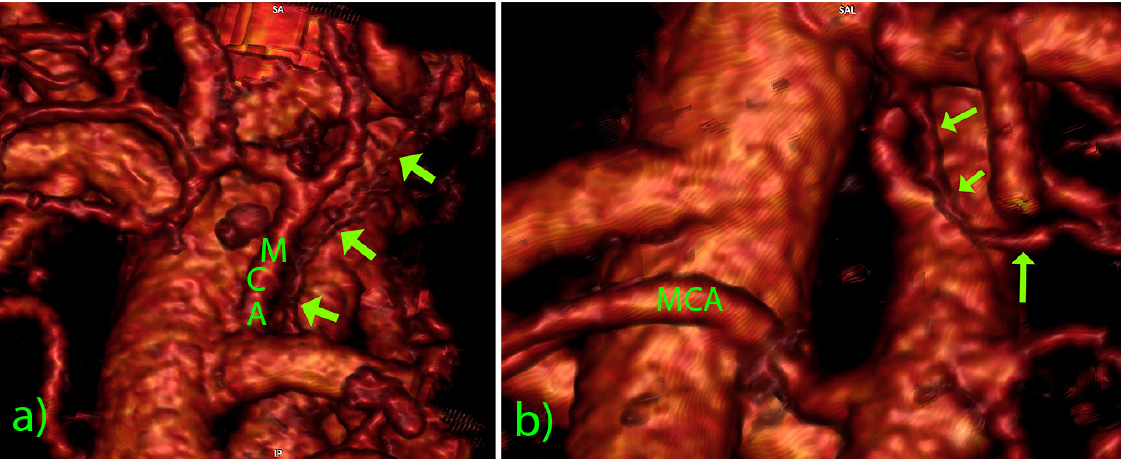
Figure 3. Three-dimensional volume rendering of lymph vessels (arrows): ( a ) longitudinal vessel paralleling the MCA; ( b ) oblique course of the lymph vessel.